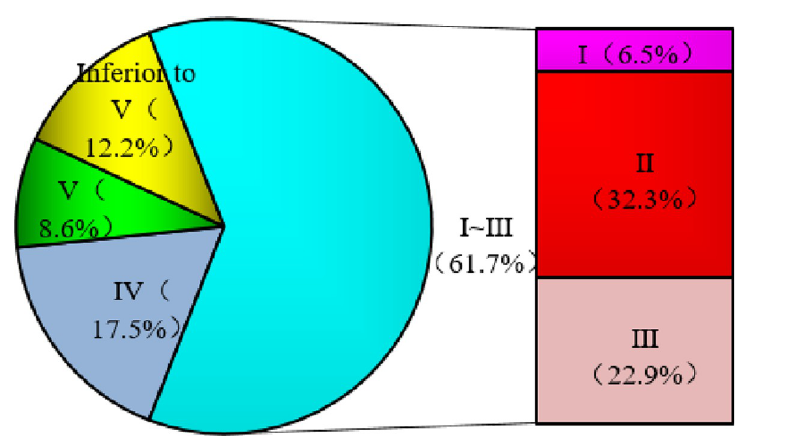
Fig 4. Proportion of water quality categories at provincial boundaries in 2019.